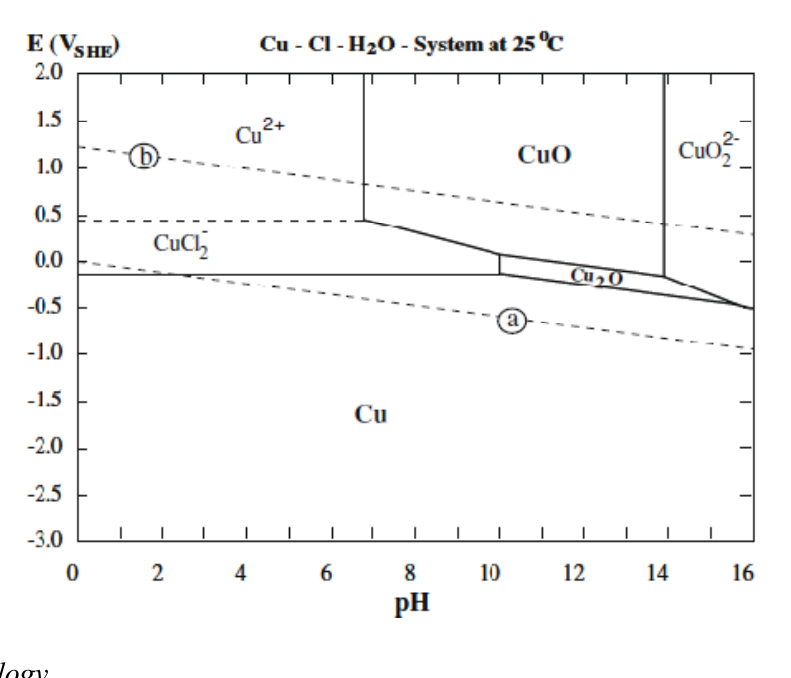
Figure 5. Potential–pH (Pourbaix) diagram of pure copper in the presence of 1 M NaCl solution. The potentials are vs. the standard hydrogen electrode